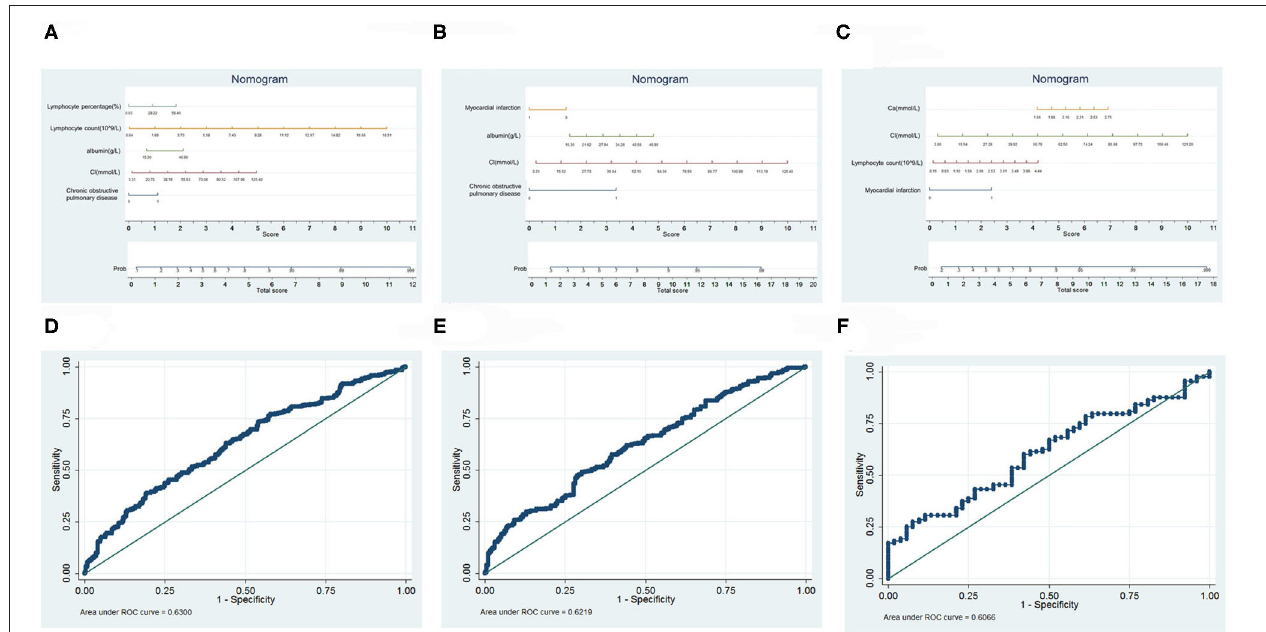
FIGURE 4 | Prediction model of infection outcome. (A) Nomogram of all infected patients. (B) Nomogram of HAP. (C) Nomogram of CAP. (D) ROC curves of all infected patients. (E) ROC curves of HAP. (F) ROC curves of